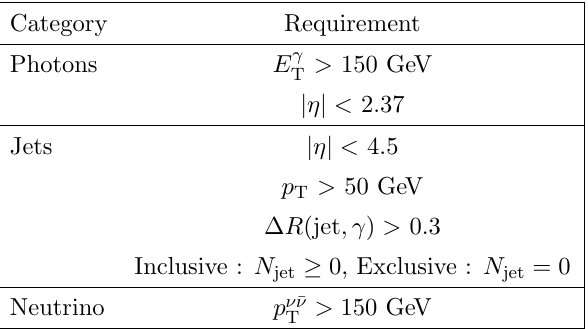
Table 2 . De(cid:12)nition of the extended (cid:12)ducial region. At particle level, p (cid:23) (cid:22) (cid:23)